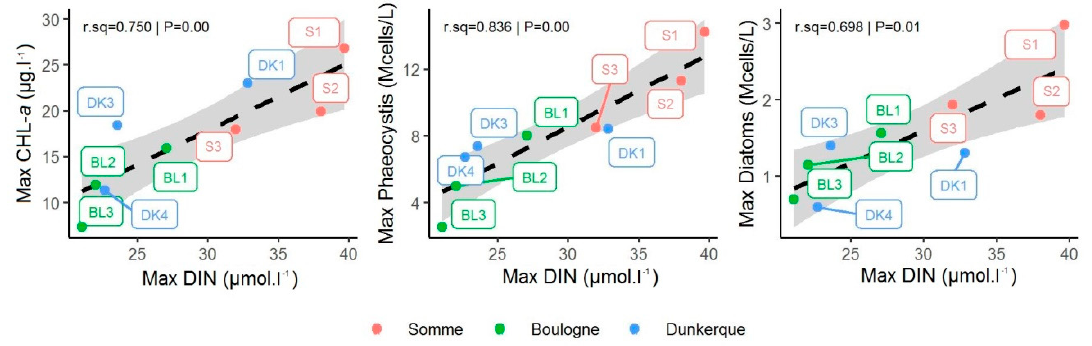
Figure 6. Relationships between Dissolved Inorganic Nitrogen (DIN) and Chlorophyll- a (Chl- a ), DIN and Phaeocystis globosa and DIN and diatom concentrations by study site during 1994–2018, using averaged maxima for the whole period.